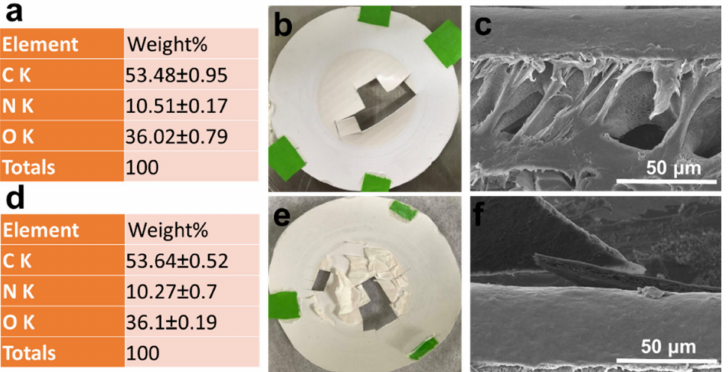
Figure 9. Characterization of non-woven/PVDF-PAA and non-woven/PVDF-PAA-GO membranes after BSA filtration for 120 h: ( a , d ) EDX results, ( b , e ) photos after freeze-drying, and ( c , f ) cross- sections of fouled composite membranes. The values of EDX are mean ± standard deviation based on two replicates (n =